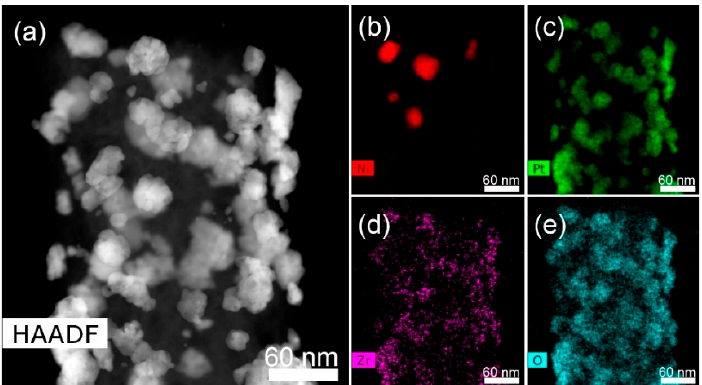
Figure 15. Elemental distribution on the CNF fragment surface (sample 10 ): ( a ) STEM HAADF image; ( b – e ) corresponding elemental maps.